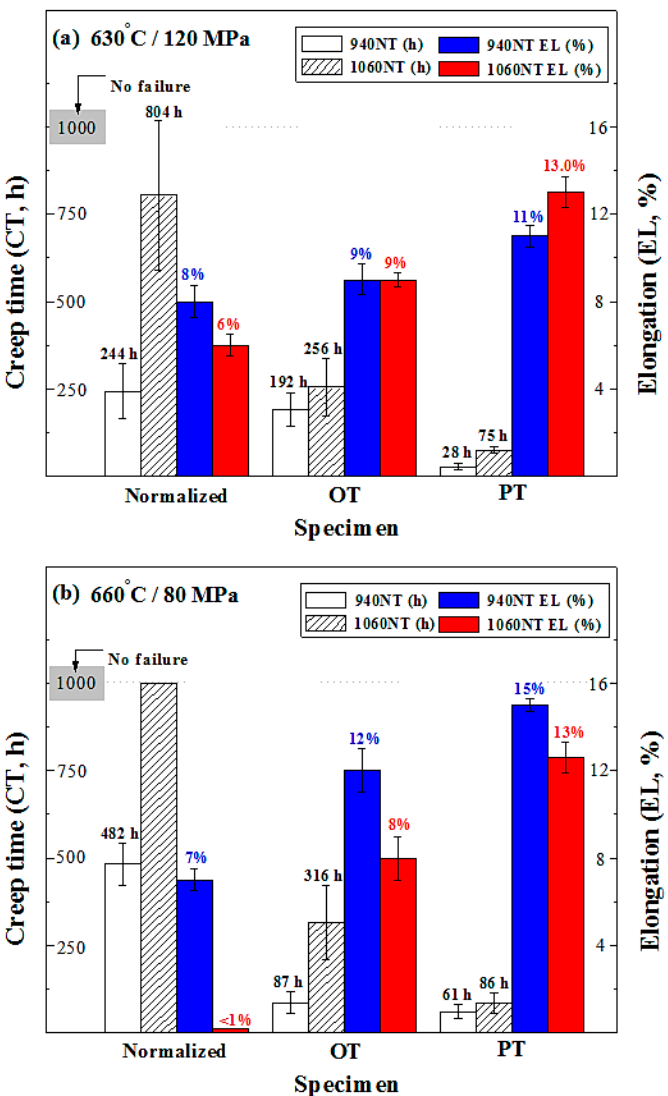
Figure 8. The short-term creep tests of various samples at ( a ) 630 °C/120 MPa, ( b ) 660 °C/80 MPa.